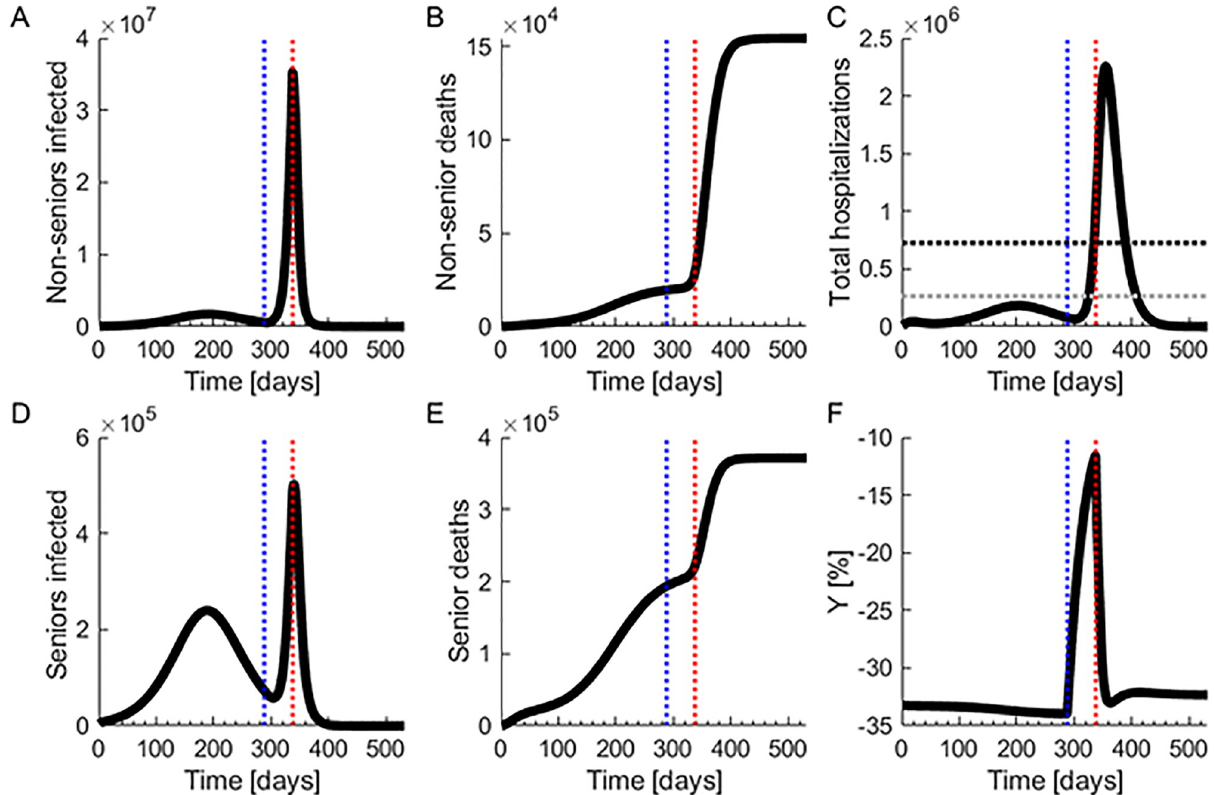
Fig 3. Sudden release of isolation measures after outbreak containment. Completely relaxing the isolation measures after the outbreak is controlled but before completely eradicating the virus leads to a second outbreak. Isolation measures are re-enforced after the second outbreak takes place and hospitals become saturated. ( A ) Number of infected non-seniors. ( B ) Number of non-senior deaths. ( C ) Total hospitalizations. The gray dotted line marks the hospital capacity strain level and the black dotted line marks the saturation level. ( D ) Number of infected seniors. ( E ) Number of senior deaths. ( F ) Change in economic output compared to the pre-pandemic state. The vertical blue dotted lines mark the time at which isolation policies are lifted and the vertical red lines mark the time at which they are re-enforced.